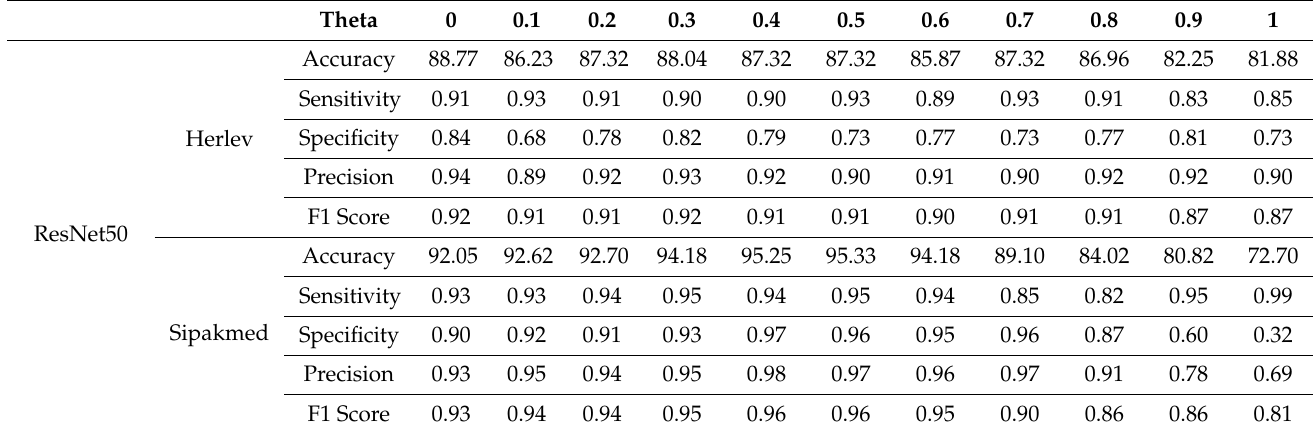
Table 13. Performance Evaluation of ResNet-50 Pre-Trained Model with Fuzzy Min–Max Neural Network.